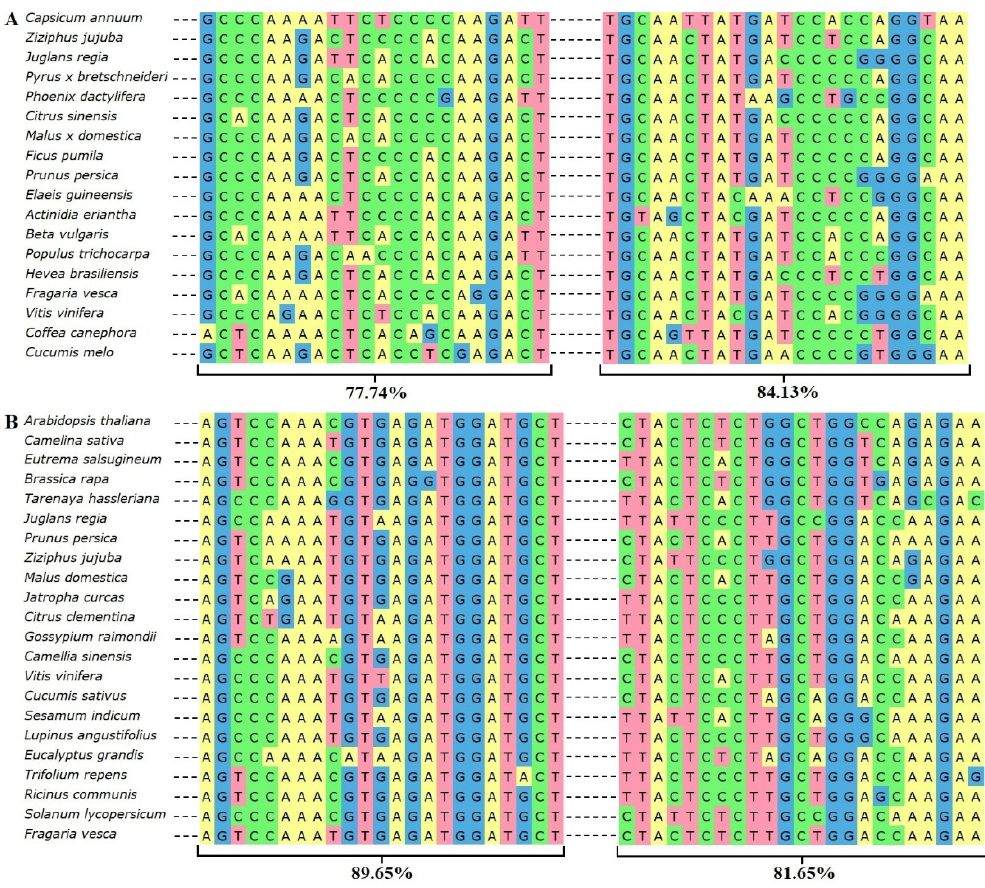
Figure 1. Alignments of the most conservative sites of PR1 ( A ) and COI1 ( B ) genes in various plants. Accession numbers of presented plants in Figure 1 are available in Table S1.